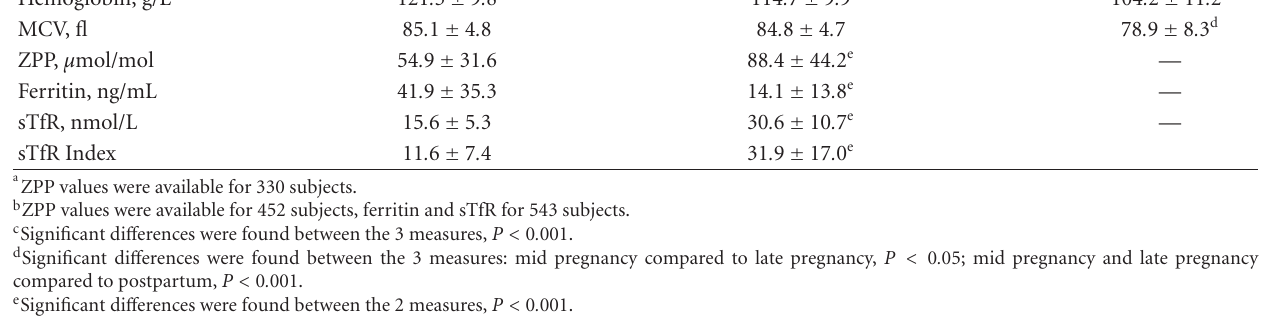
Table 3: Maternal iron status in the confirmatory sample (mid- and late pregnancy, 3days postpartum). Iron measure